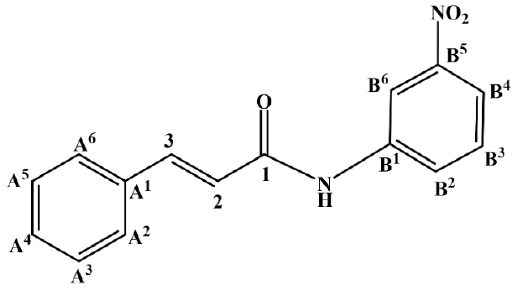
Figure 1. Ring nomenclature (A and B rings).